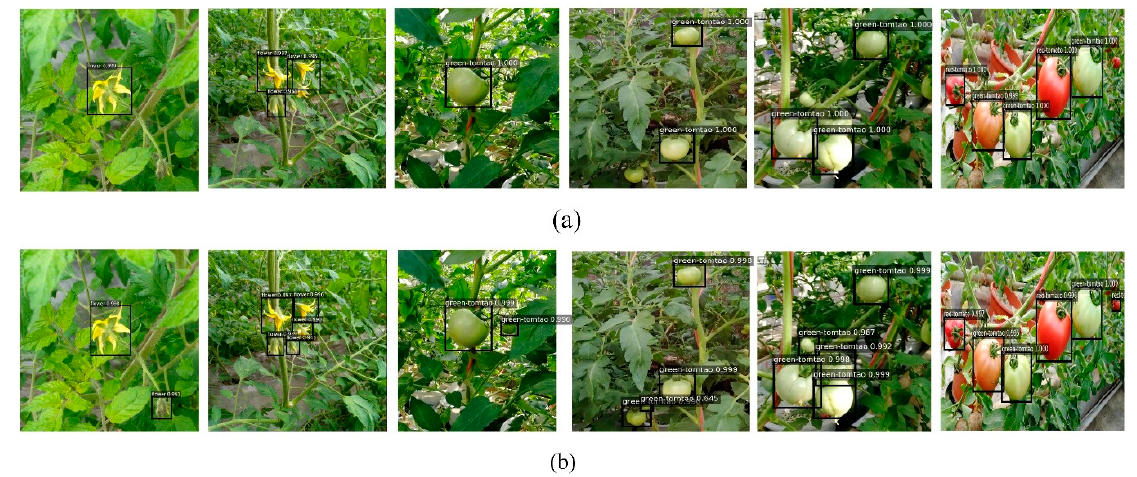
Figure 5. Visualization results using different anchor sizes. ( a ) Testing results of model 1 using the original anchor sizes (8 × 16, 16 × 16, 32 × 16 pixels); ( b ) Testing results of model 2 using updated anchor sizes (4 × 16, 8 × 16, 16 × 16 pixels). The reason for this phenomenon is that the original anchor size is manually pre-set, and is suitable for the larger target of the voc2007 dataset. However, the dataset in this paper contains targets such as small tomatoes and flowers. If the original size is used, small targets will not be detected; thus, K-means need to be used to cluster the appropriate anchors.